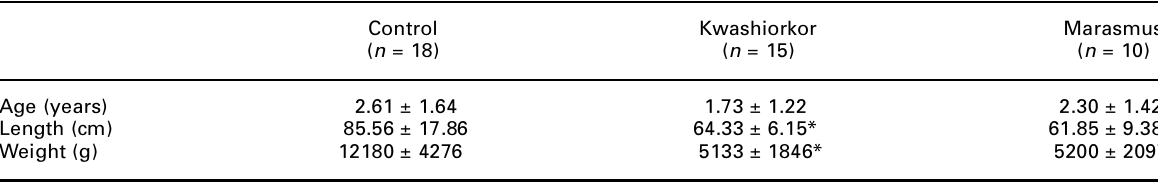
Table 1. Antropometric measurements of groups and controls